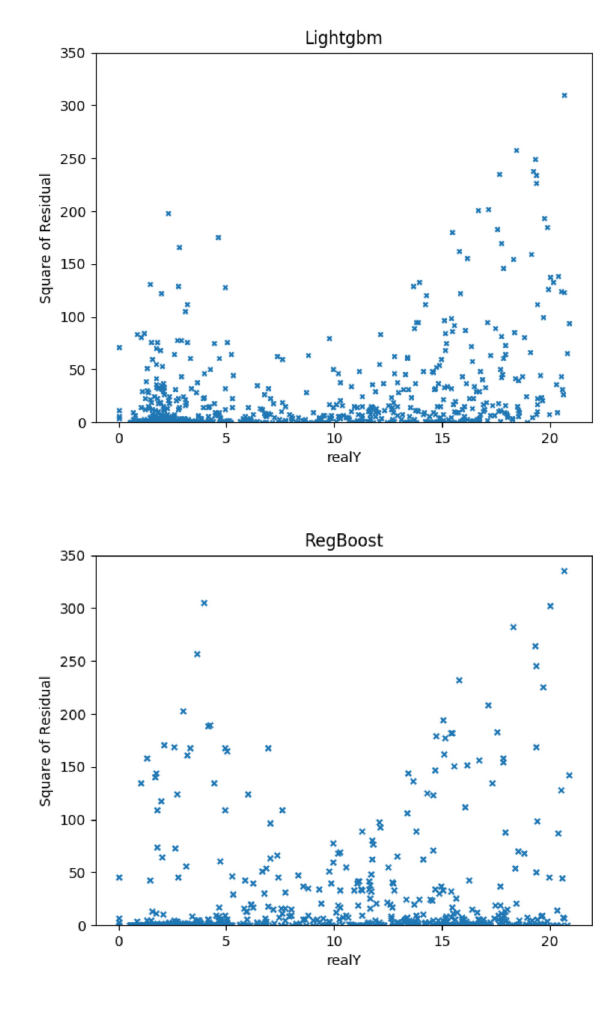
Figure 7. Square of